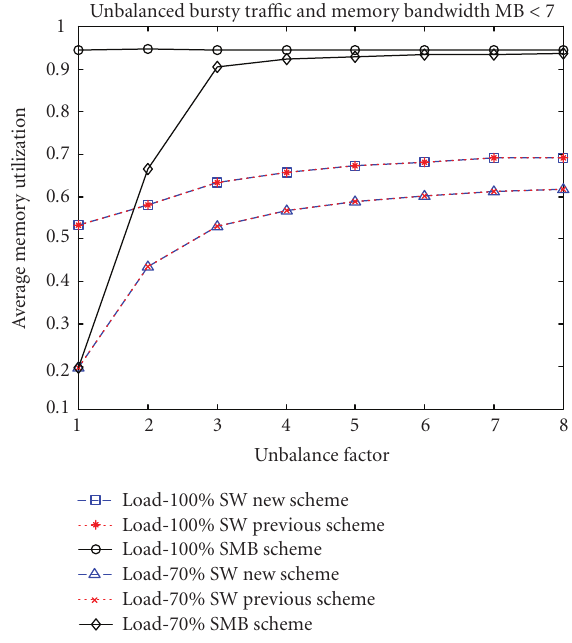
Figure 10: Average memory utilization with speed-up of memory modules.